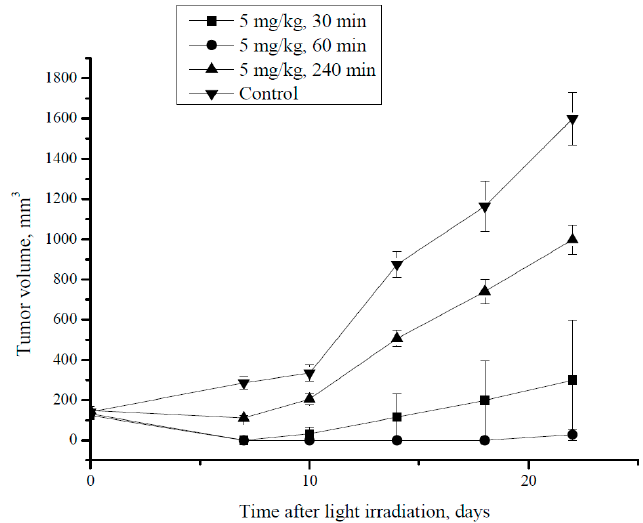
Figure 6. CT26 tumor growth dynamics after PDT at different time intervals i.v. post MNP-HSA@PS injection.